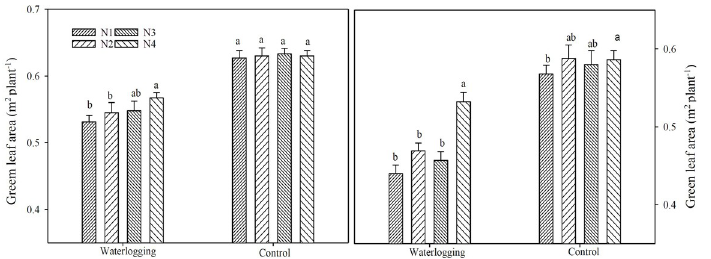
Fig 1. Green leaf area at the silking stage across differing nitrogen regimes. The error bars represent the standard errors of the mean. Different letters above the bars indicate significant differences (p < 0.05) among different N regimes. N1: 100% N applied as basal fertilizer, N2: 70% N applied as basal fertilizer and 30% N applied at the jointing stage, N3: 50% N applied as basal fertilizer and 50% N applied at the jointing stage, N4: 30% N applied as basal fertilizer, 50% N applied at the jointing stage and 20% N applied at the big flare stage.